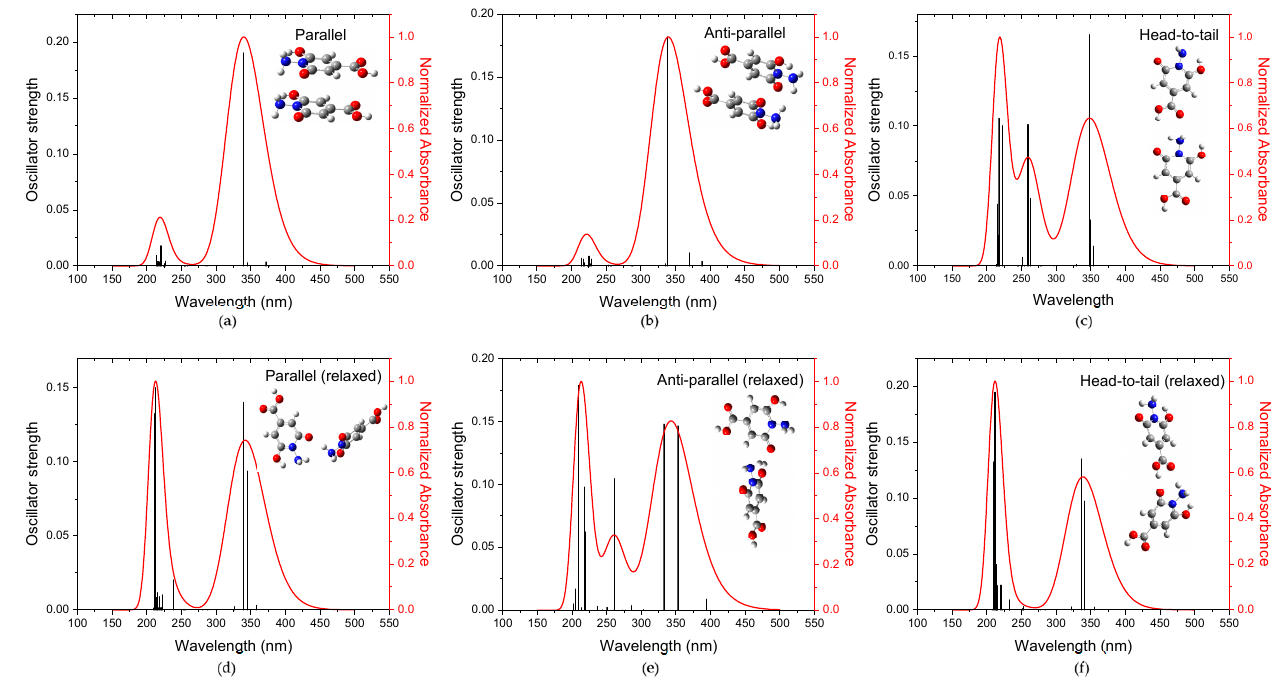
Figure 7. Simulated absorbance spectra and oscillator strength of parallel, anti-parallel and head- to-tail dimers for fixed geometries ( a – c ) and for the corresponding relaxed geometries ( d – f ). The insets report the ball-and-stick representation of the structures (H atom—white sphere, C atom—grey sphere, N atom—blue sphere, O atom—red sphere).